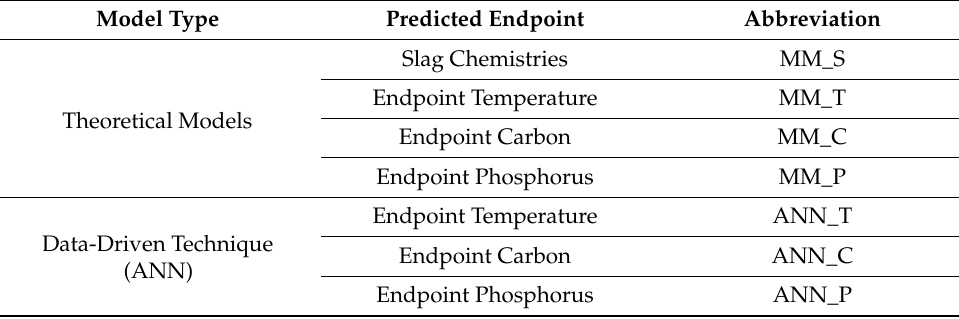
Table 5. Single models that are included in the hybrid model